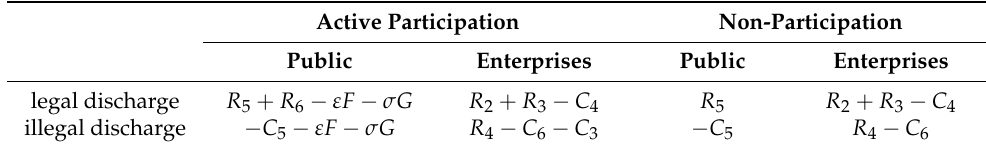
Table 3. The payoff matrix of the public and enterprises. Active